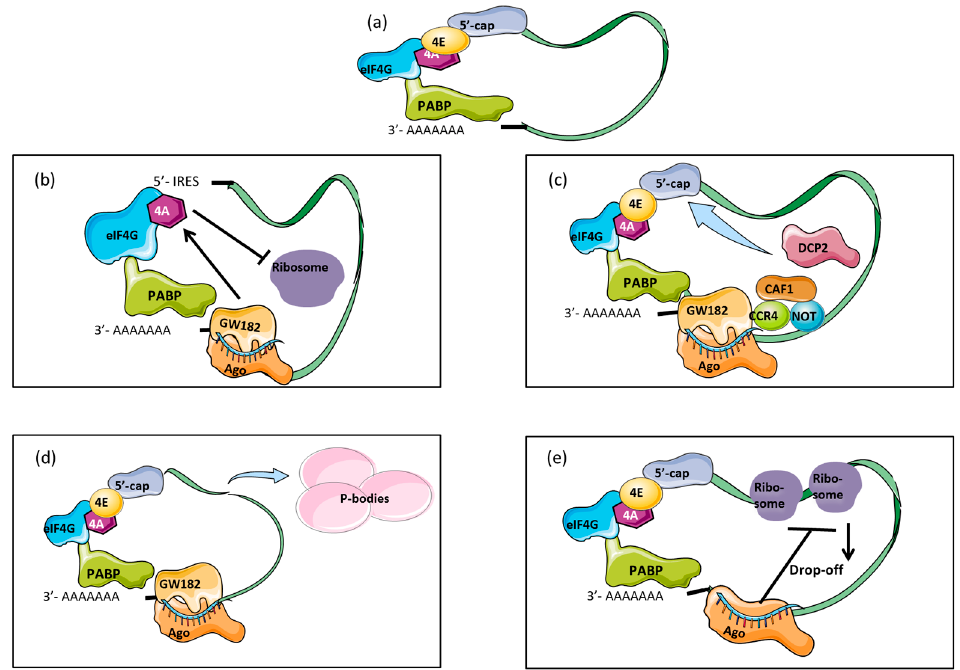
Figure 2. miRNA methods of translational repression. ( a ) mRNA is effectively translated when it possesses a 5 ′ -cap and 3 ′ -poly(A) tail. At the initiation of translation, PABP associates with eIF4G which interacts with the 5 ′ -cap structure forming a circular mRNA protected from degradation; ( b ) In the cap-independent mechanism, IRES binds to EIF4G without the need of EIF4E. After miRNA-mRNA binding, translational repression is mediated by EIF4A on the 5 ′ UTR preventing the action of ribosomes; ( c ) During the 5 ′ –3 ′ decay pathway, GW182 as part of RISC, interacts with PABP and recruits the CAF1-CCR4-NOT complex which deadenylates mRNA. After deadenylation, mRNA is decapped by DCP2 and finally degraded; ( d ) mRNA degradation associated to p-bodies occurs after binding of RISC containing the miRNA. mRNA is sequestered to cytoplasmic P-bodies, which are centres of mRNA degradation containing key proteins necessary for translational repression; ( e ) In the ribosome drop-off model, miRNA associated with Argonaute binds to the mRNA target and has a distanced effect on translating ribosomes at multiple sites causing the ribosomes to drop-off. eIF4: eukaryotic translation-initiation factor 4; PABP: cytoplasmic poly(A) binding protein; IRES: internal ribosome entry site; DCP2: decapping enzyme 2.